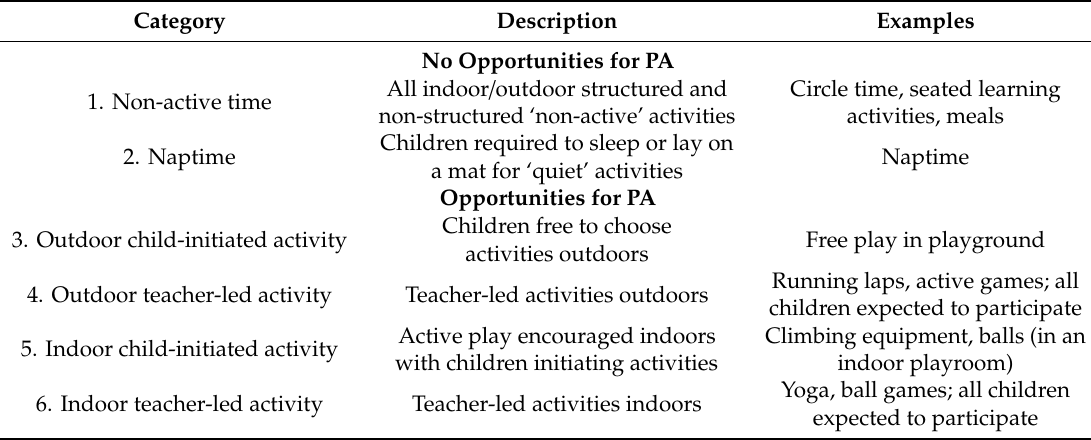
Table 1. Categories of observed